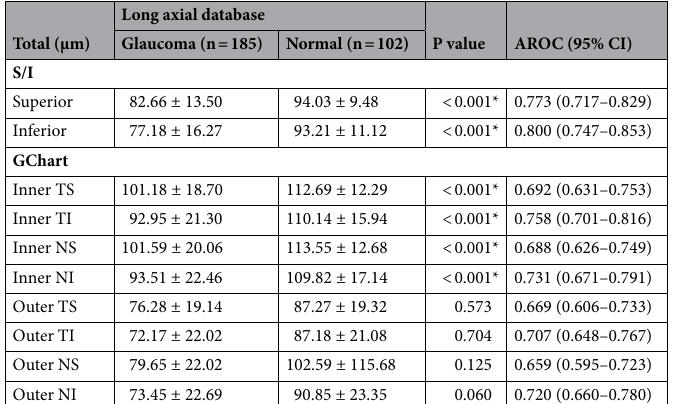
Table 2. Comparison of the analysis chart parameters of mGCC thickness between highly myopic glaucoma group and highly myopic normal group (long axial database). AROC Covariate-Adjusted Receiver Operating Characteristic, CI Confidence Interval, S/I Superior/Inferior, TS Temporal-Superior, TI Temporal-Inferior, NS Nasal-Superior, NI Nasal-Inferior. *Statistical significance shown at p < 0.05.